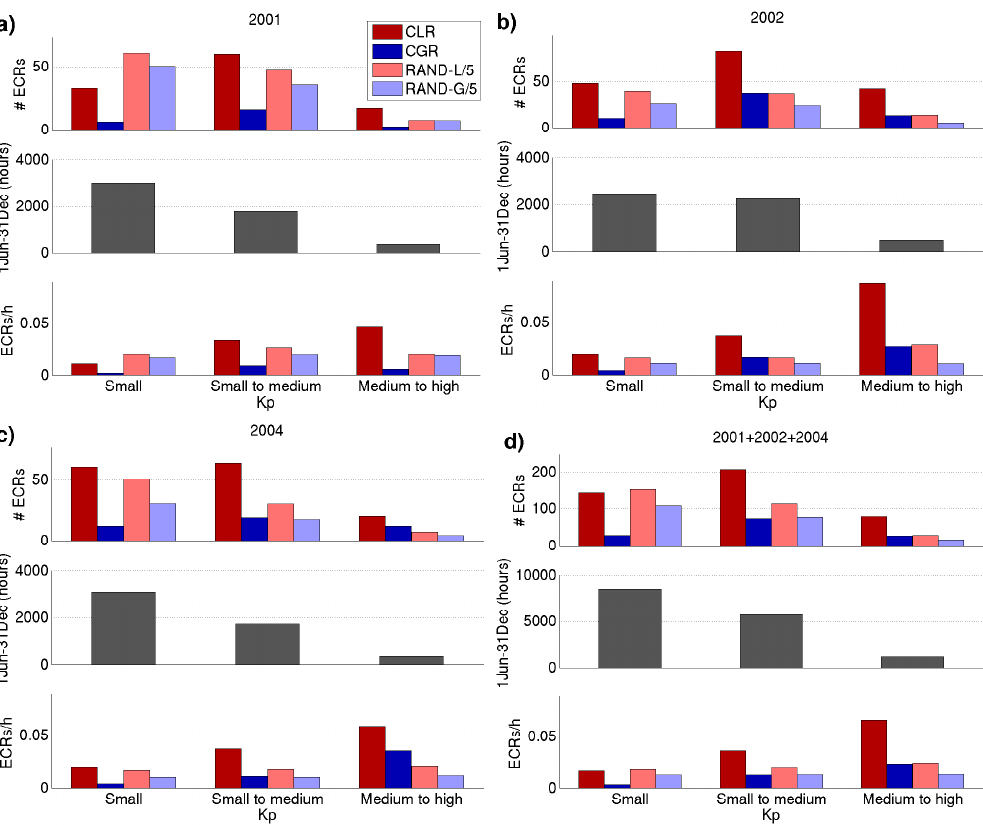
Fig. 2. The occurrence of ECR and RAND events during different magnetospheric activity as described by Kp in 2001 (a) , 2002 (b) , 2004 (c) , and within the entire data base comprising all three years (d) . The three Kp bins correspond to 0 ≤ Kp ≤ 2, 2 +≤ Kp ≤ 4, and 4 +≤ Kp ≤ 9 + . Red and blue correspond to CLRs and CGRs, respectively, while light red and light blue signify RAND-Ls and RAND-Gs. The top panels in each figure show the actual number of energy conversion events. Note however that the number of RAND events is divided by 5. The middle panels show the normal variation of Kp over the years. The bottom panels contain the number of events per hour of Cluster observation for the selected Kp values by dividing the number of events in the top panels with the normalizing data in the middle panels. Note the different scalings of the axes.